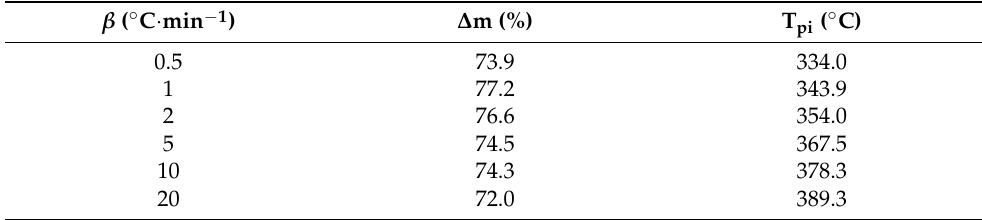
Figure 2. TG and DTG curves of BIIR in air at different heating rates: ( a ) 0.5 °C min − 1 , ( b )1 °C min − 1 , ( c ) 2 °C min − 1 , ( d ) 5 °C min − 1 , ( e ) °C min − 1 , and ( f ) 20 °C min − 1 . Table 1. Decomposition temperatures (T pi /°C) of BIIR at different heating rates in Table 1. Decomposition temperatures (T pi / ◦ C) of BIIR at different heating rates in air.